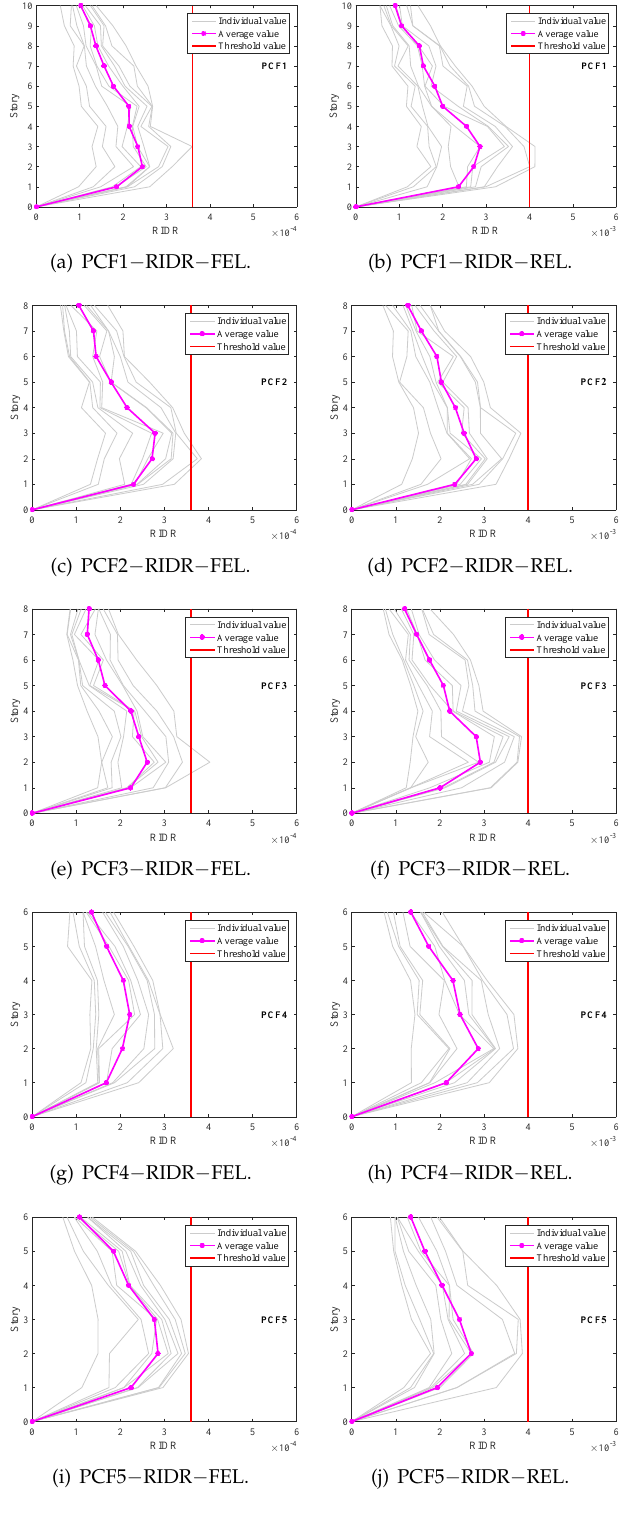
Figure 10. RIDR development along the structural height under the stochastic nonstationary earth- quakes for both the FEL and the